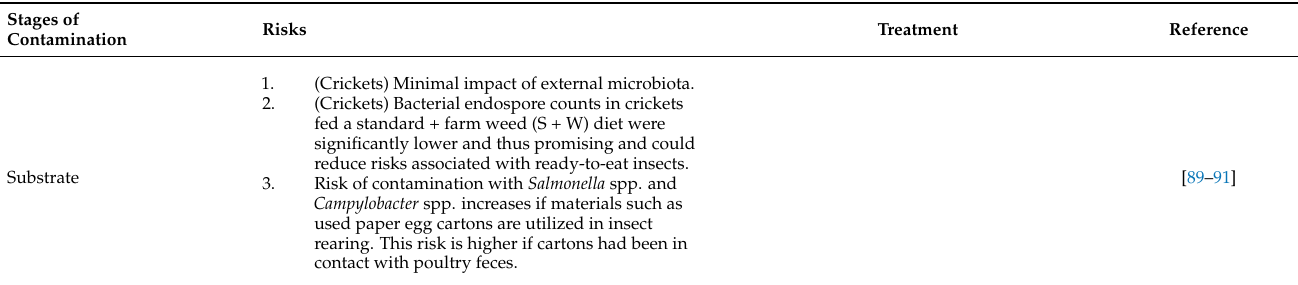
Table 1. Possible routes of contamination of edible insects and insect-based